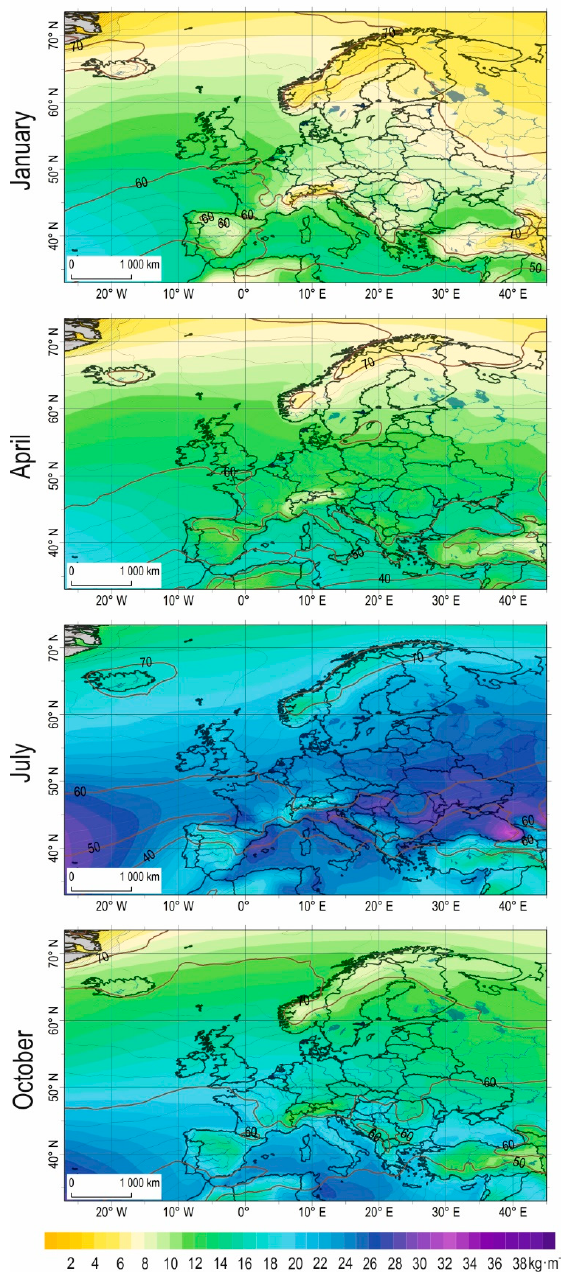
Figure 1. Climatology of monthly water vapor content in the atmosphere (TCWV) (kg·m − 2 , colored) and relative humidity (RH) (%, solid lines) (1981–2015).